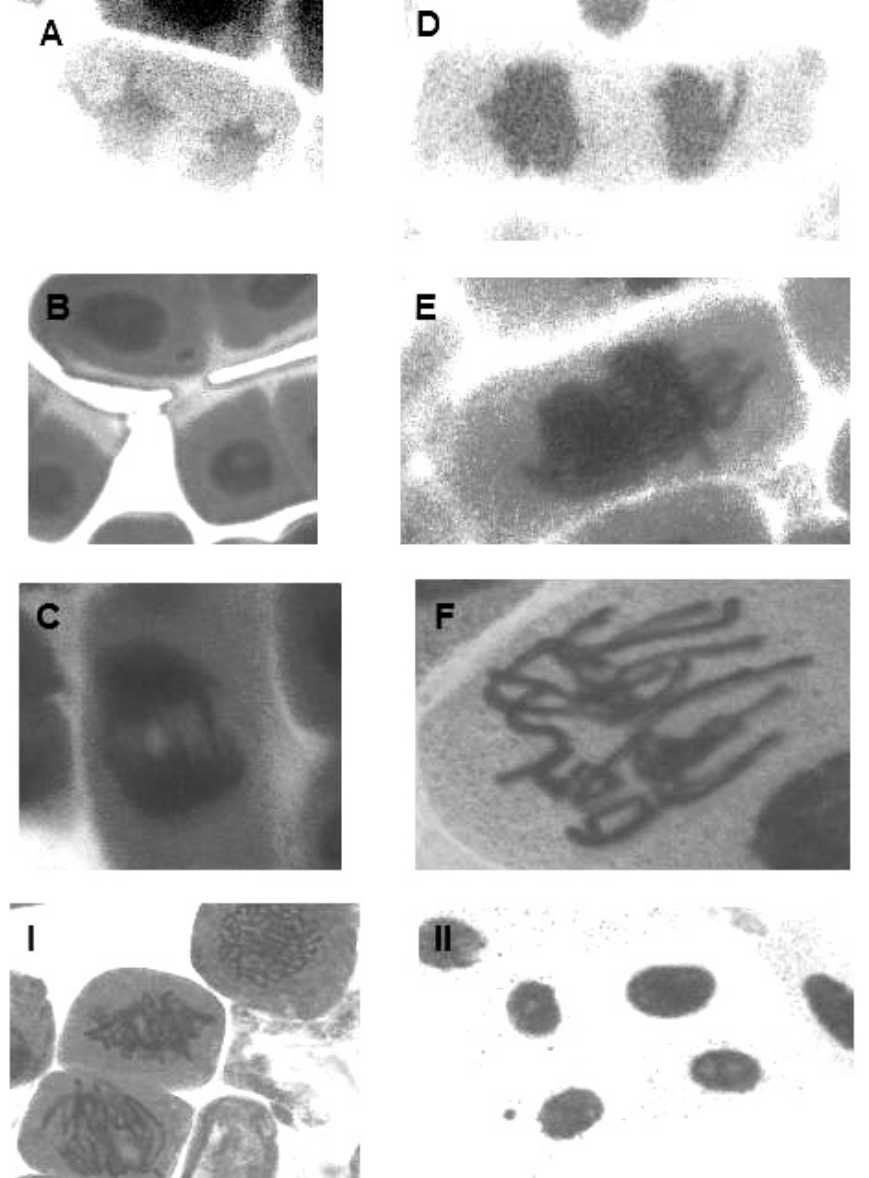
Fig. 1 – Different types of aberration induced by NDEA in Allium cepa root tips: (A) lagging chromosome at anaphase (25mM); (B) micronucleus at interphase (5 mM); (C) bridge formation (0.5 mM); (D) lagging chromosome at anaphase (0.5 mM); (E) stickiness formation (0.1 mM); (F) chromosome break at metaphase (0.1 mM). (I) normals prophase, metaphase and anaphase induced by negative control (water); (II) micronucleus and high synthesis of protein induced by positive control (MH 30 μ